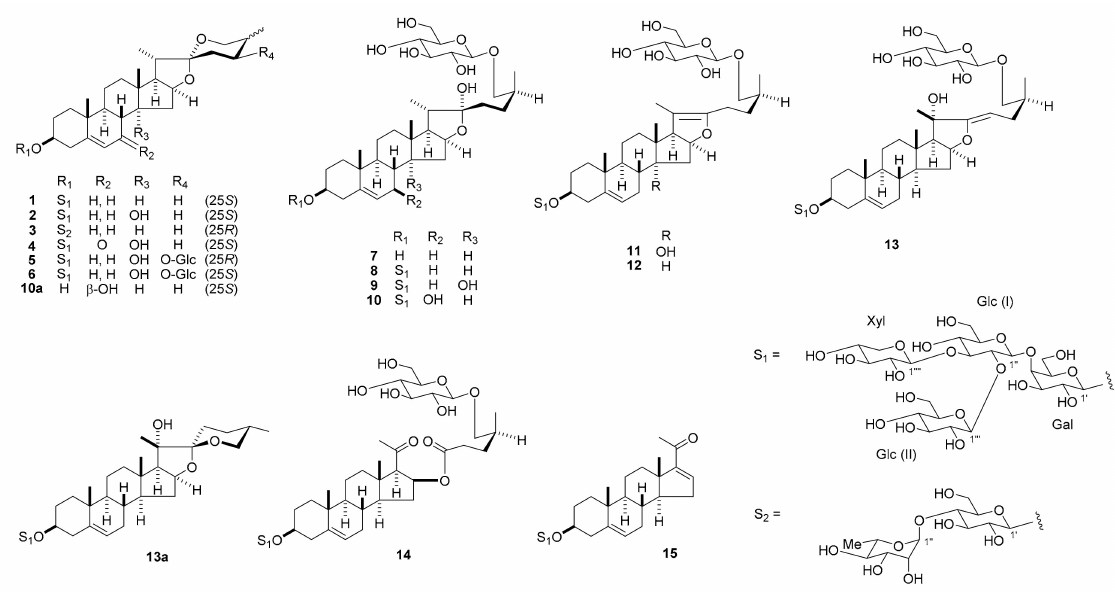
Figure 1. Steroidal glycosides from Convallaria majalis